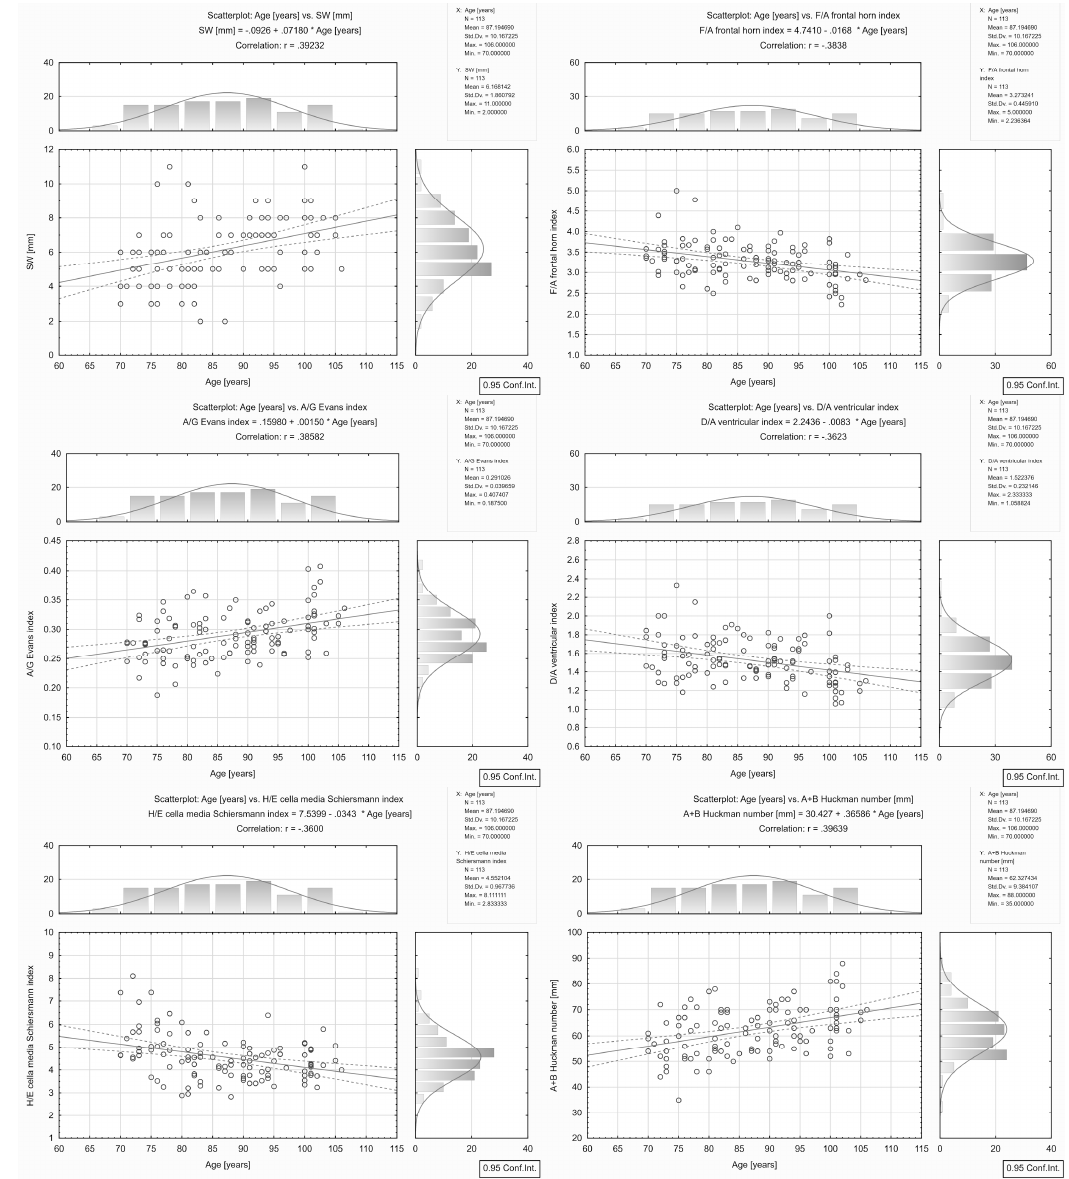
Figure 3. Correlations between brain atrophy parameters/indices: SW, F/A, A/G, D/A, H/E, A + B and age in the group of all the patients aged 70–106.